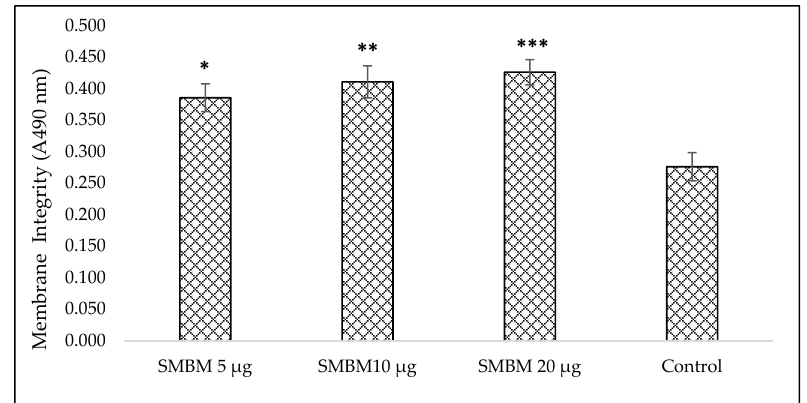
Figure 3. The amount of lactate dehydrogenase (LDH) released in MCF-7 cells treated with SMBM. The SMBM treated cells elevated the LDH release compared to the control. Among the groups, the maximum LDH release is seen in 20 μ g SMBM treated cells. The data represent the mean ± SEM. Significantly different at * p < 0.05, ** p < 0.01 and *** p < 0.001 when compared to the control. SMBM— S. mundagam bark methanol extract.